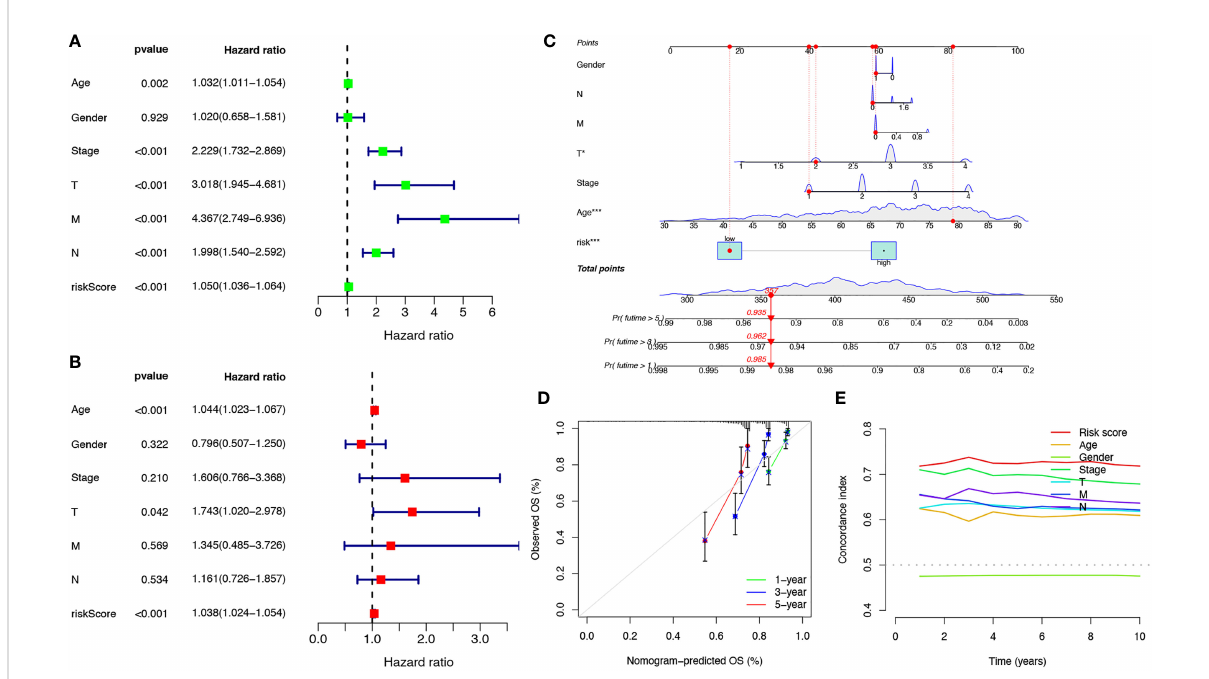
FIGURE 4 Veri fi cation of the independent prognostic ability and clinical predictive ability of the 10 cuproptosis-related lncRNAs signature for COAD in TCGA. Forest plots of univariate (A) and multivariate (B) Cox regression analyses revealed that risk score could be an independent prognostic factor. The nomogram for both clinical-pathological factors and risk score could predict the probability of survival based on the total points (C) . The calibration curves for predicting patients ’ OS at 1-year (green line), 3-year (blue line), and 5-year (red line) in the training cohort (left), internal validation cohort (middle), and external validation cohort (right) (D) . The C-index curves for assessing the discrimination ability of risk score and other clinical factors at each time point (E) . nsP >= 0.05, *P < 0.05, **P < 0.01, ***P <